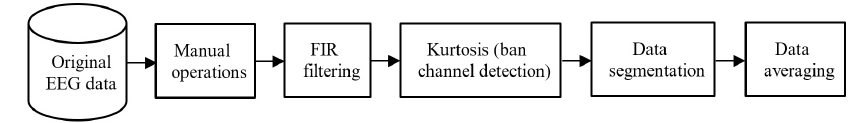
Figure 1. Work-flow of EEG data